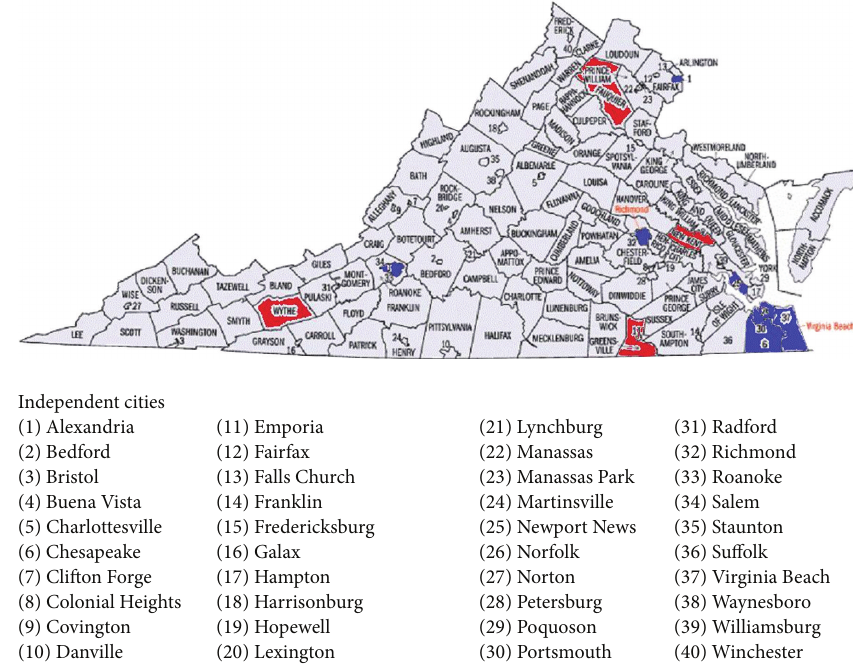
Figure 1: The clustering results of 121 counties in Virginia according to hate